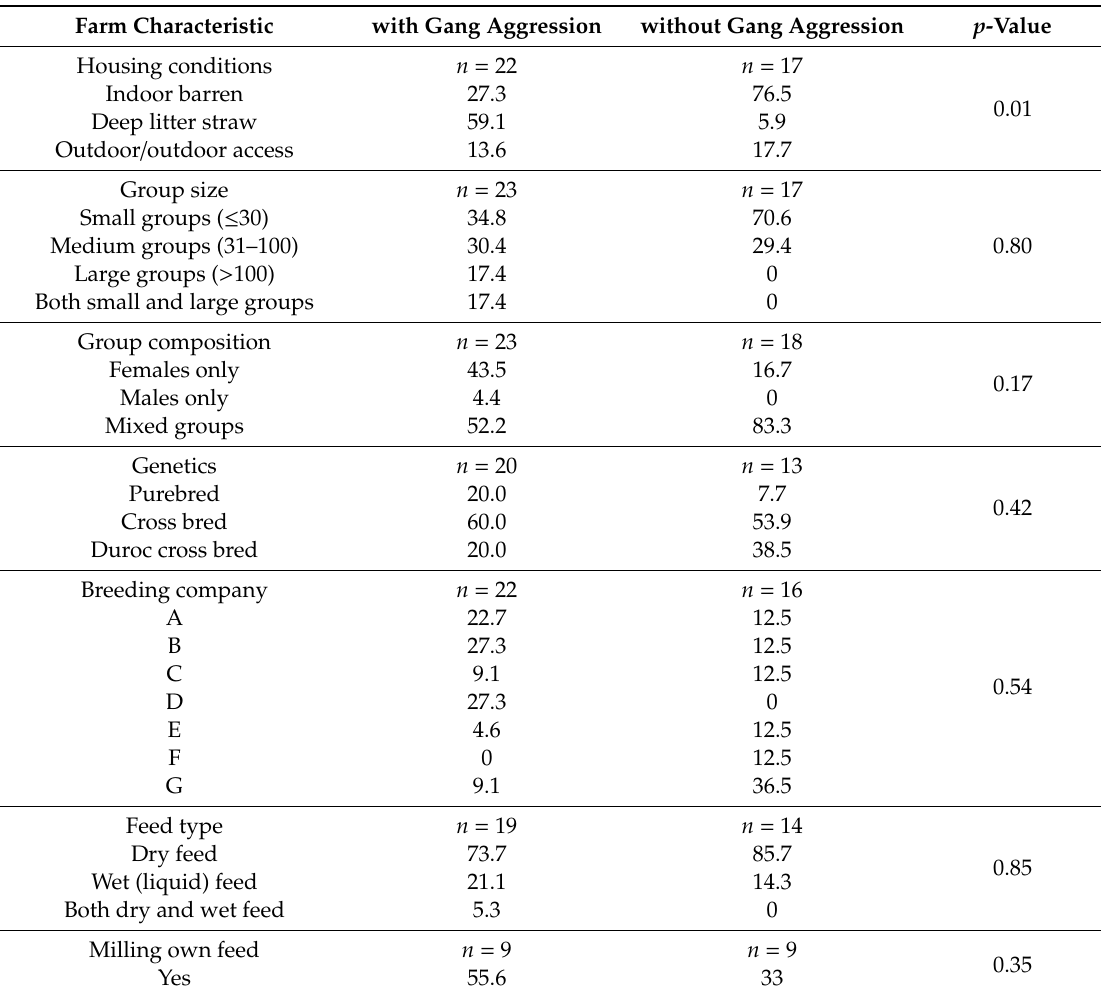
Table 2. Farm characteristics in percentages, according to survey data from farms with lethal gang aggression ( n = 23) and without ( n = 19). The first row for each characteristic shows the number of responses per category. Percentages may slightly deviate from a sum of 100% due to rounding of